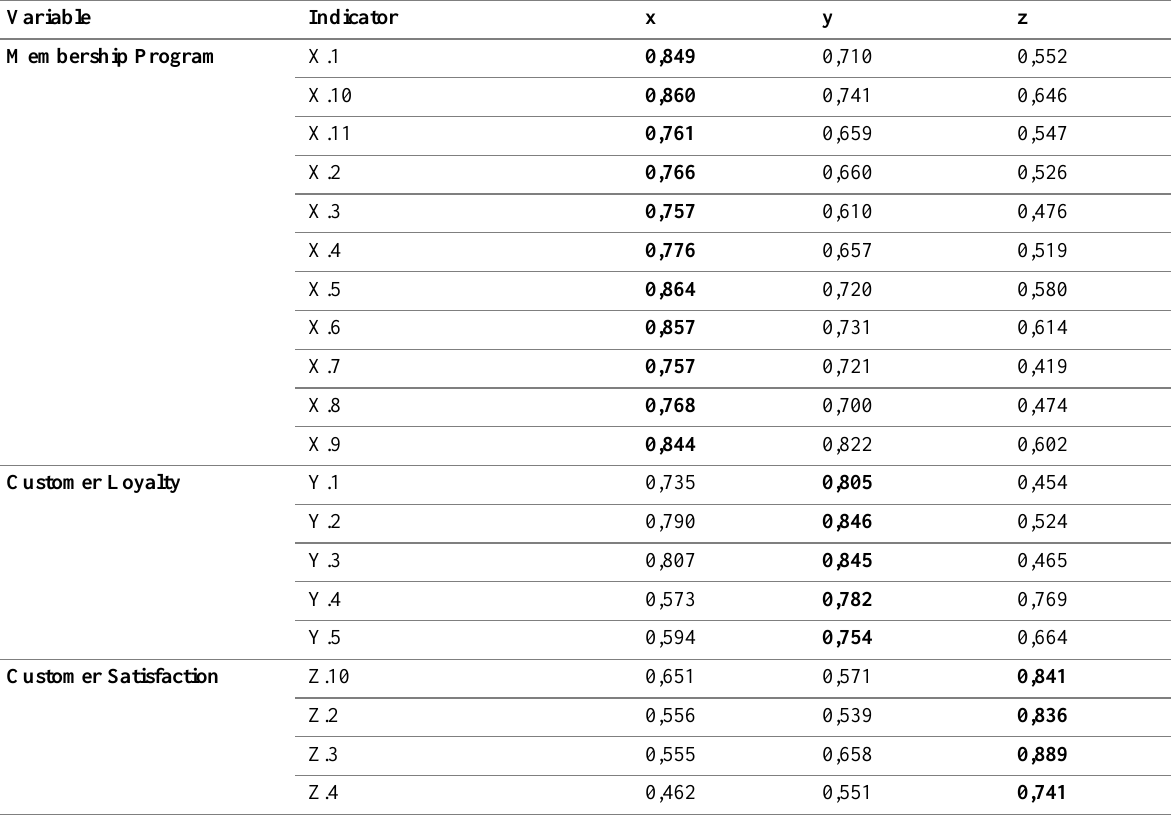
Table 2: Discriminant Validity Test Using Cross Loading